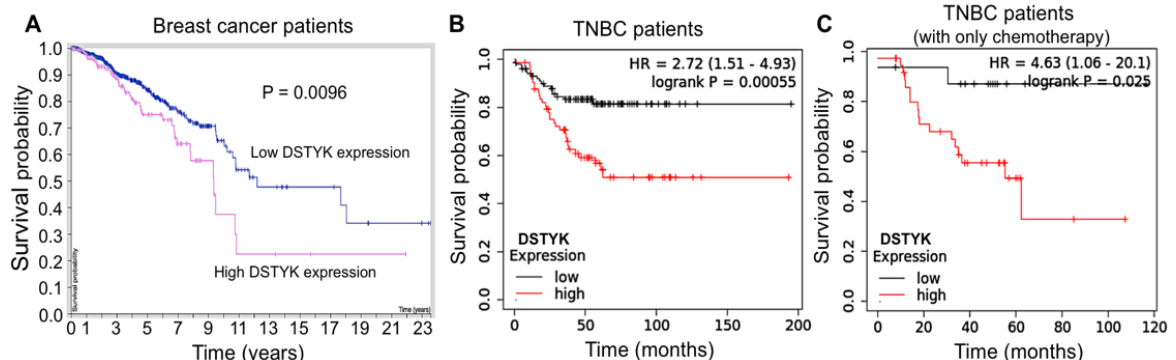
Figure 1. Statistical analysis of DSTYK-related survival probability in breast cancer patients. ( A ) Survival curves of breast cancer patients with differential DSTYK expression published in The Human Protein Atlas (HPA). Patients include all four cancer stages and those stages are not available (n/a). The survival probabilities were generated and are publicly available at website (www.proteinatlas.org, accessed on 14 December 2021). ( B ) Survival curves of TNBC patients and ( C ) TNBC patients only treated with chemotherapy from the Kaplan-Meier Plotter dataset statistical analysis (https://kmplot.com/analysis/index.php?p=service&cancer=breast, accessed on 14 December 2021).